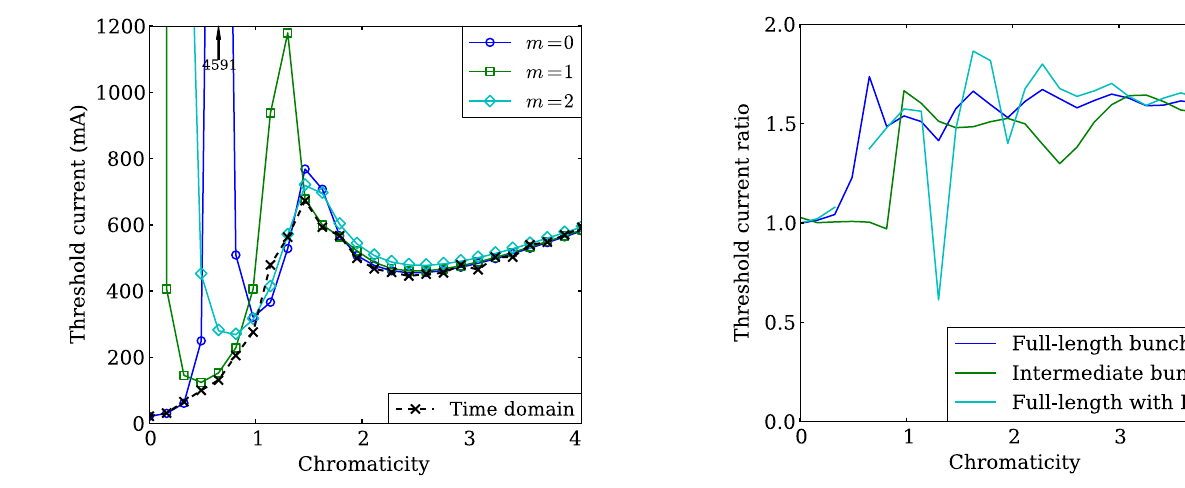
FIG. 19. Threshold current for the coupled-bunch resistive-wall instability in the 3 GeV ring with a BBR included for the case with a lengthened Gaussian bunch. Results of macroparticle simulations in the time domain (dashed line) are compared with those obtained using a frequency domain computation (solid lines).